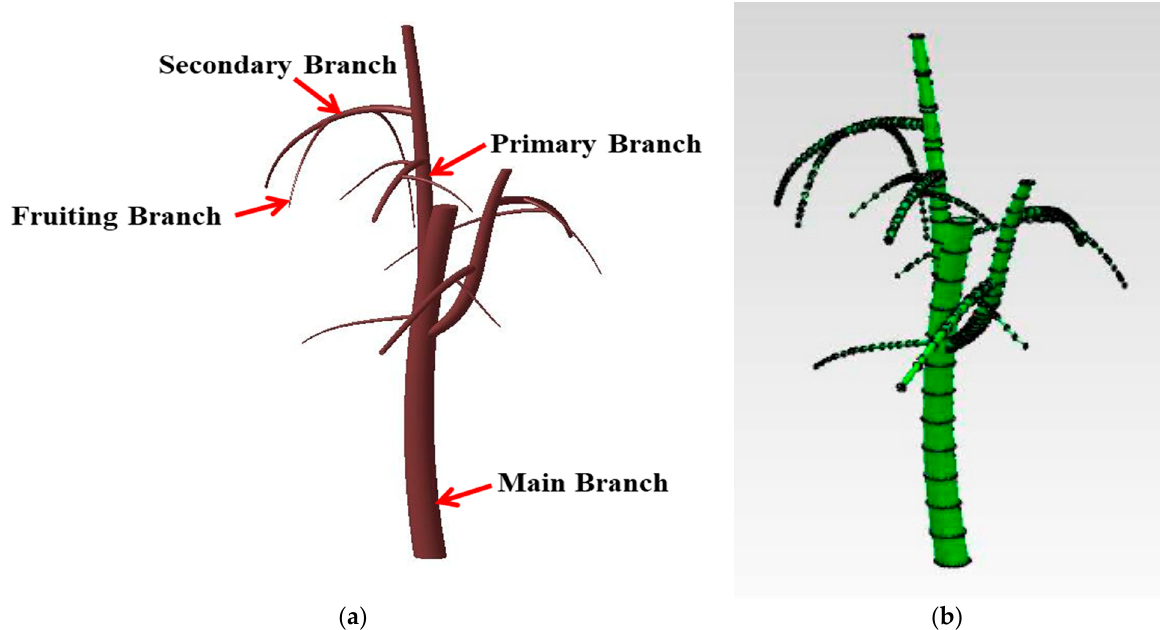
Figure 1. The 3D model of the L. barbarum shrub ( a ) and the 3D model of the L. barbarum shrub with reference points ( b ).